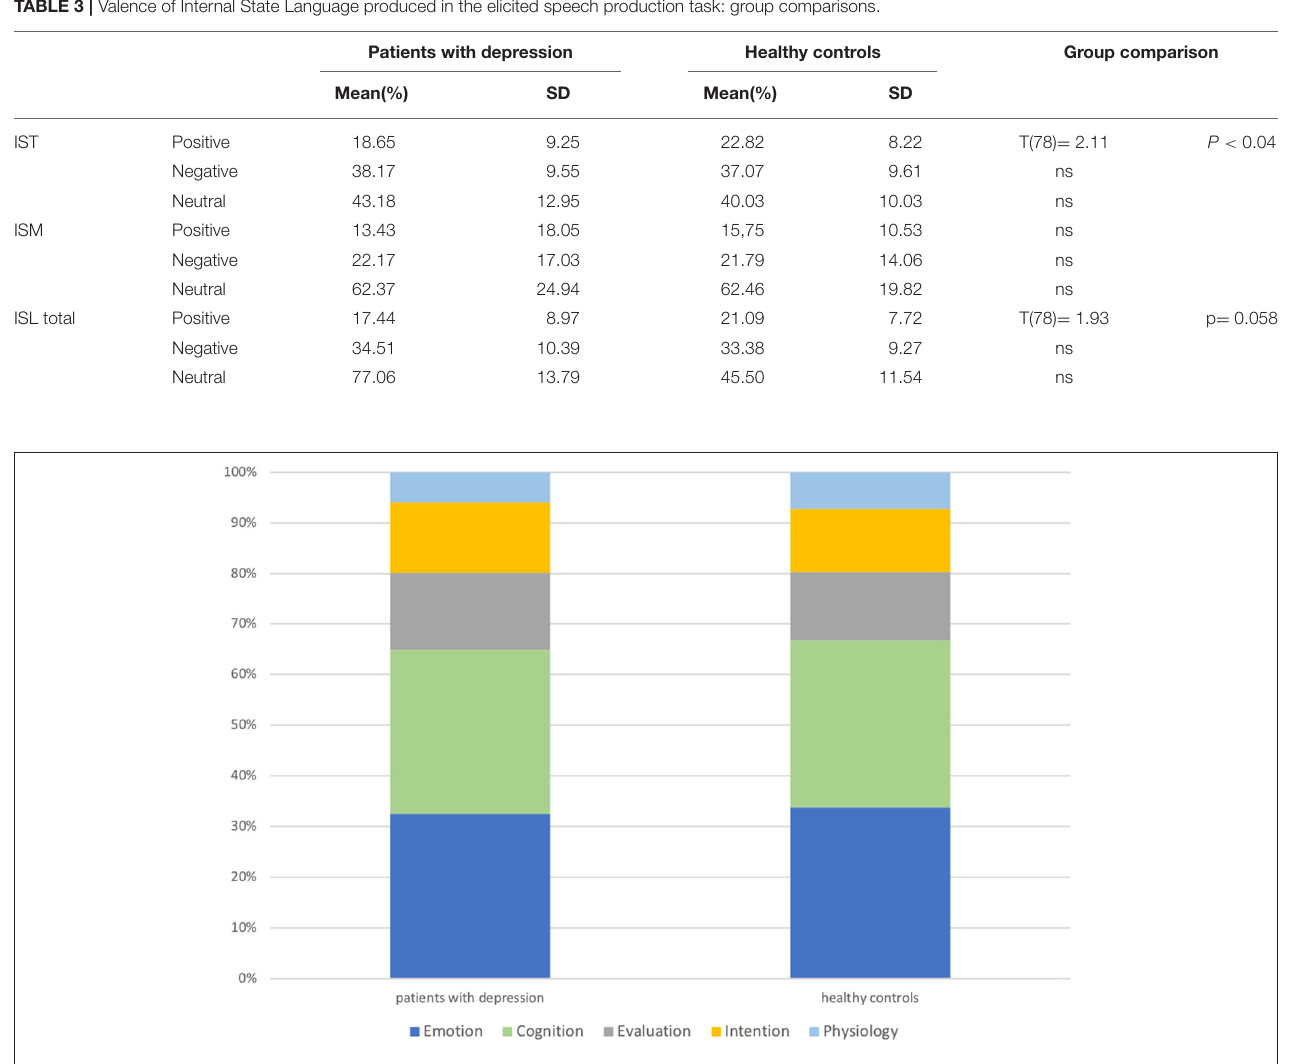
Frontiers in Psychology |